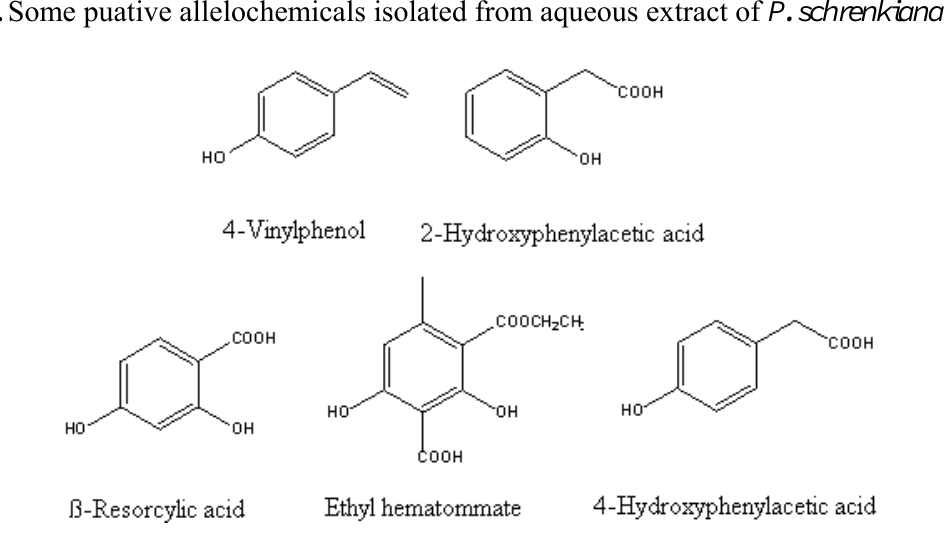
Figure 11. Some puative allelochemicals isolated from aqueous extract of P. schrenkiana